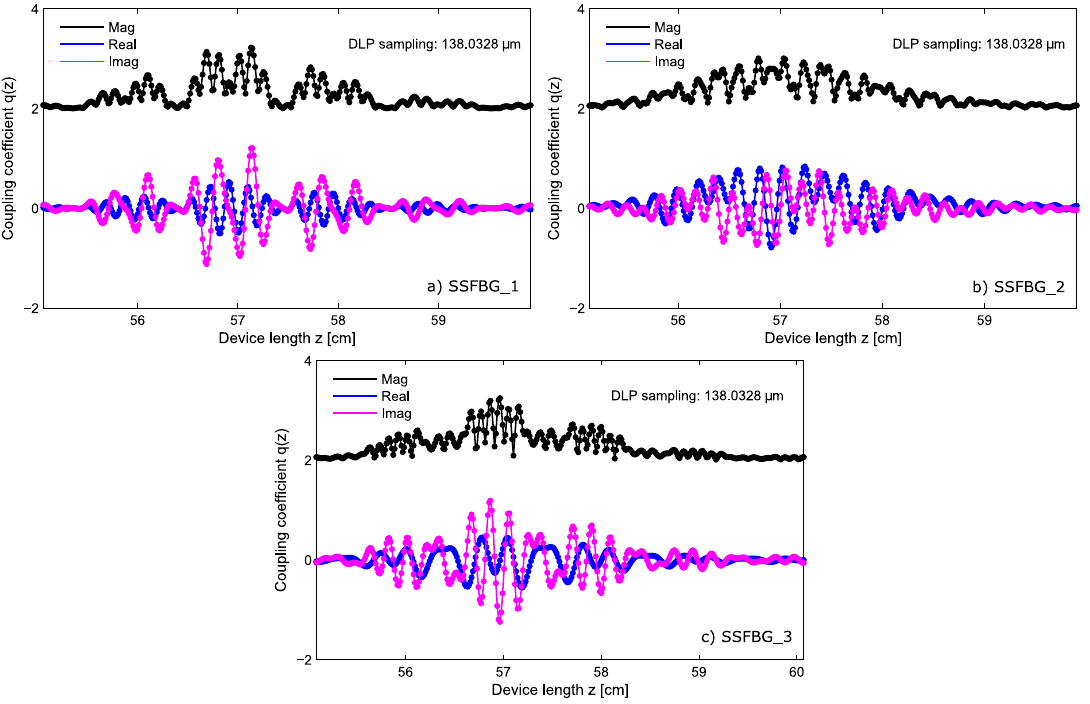
Figure 6. Complex coupling coefficient q ( z ) , for the three designed SSFBG sensing devices. The magnitude as well as the real and imaginary components for each sensing device are shown in ( a – c ). The amplitude of the coupling coefficient is proportional to the ac index profile of the grating.